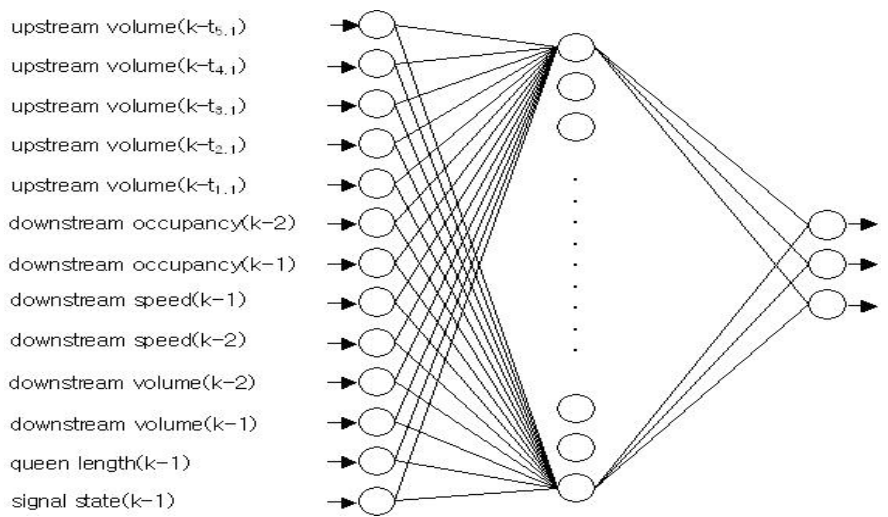
Figure 2. The traffic accident prevention communication algorithm.